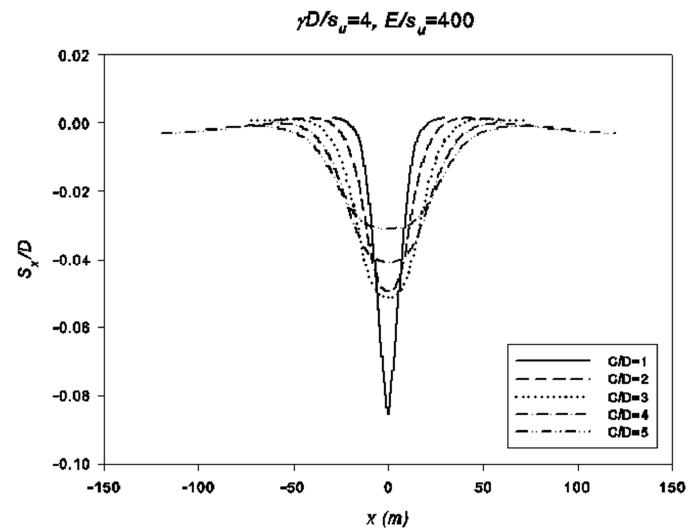
Figure 13. A typical regression of the Gaussian equation to the FLAC data.